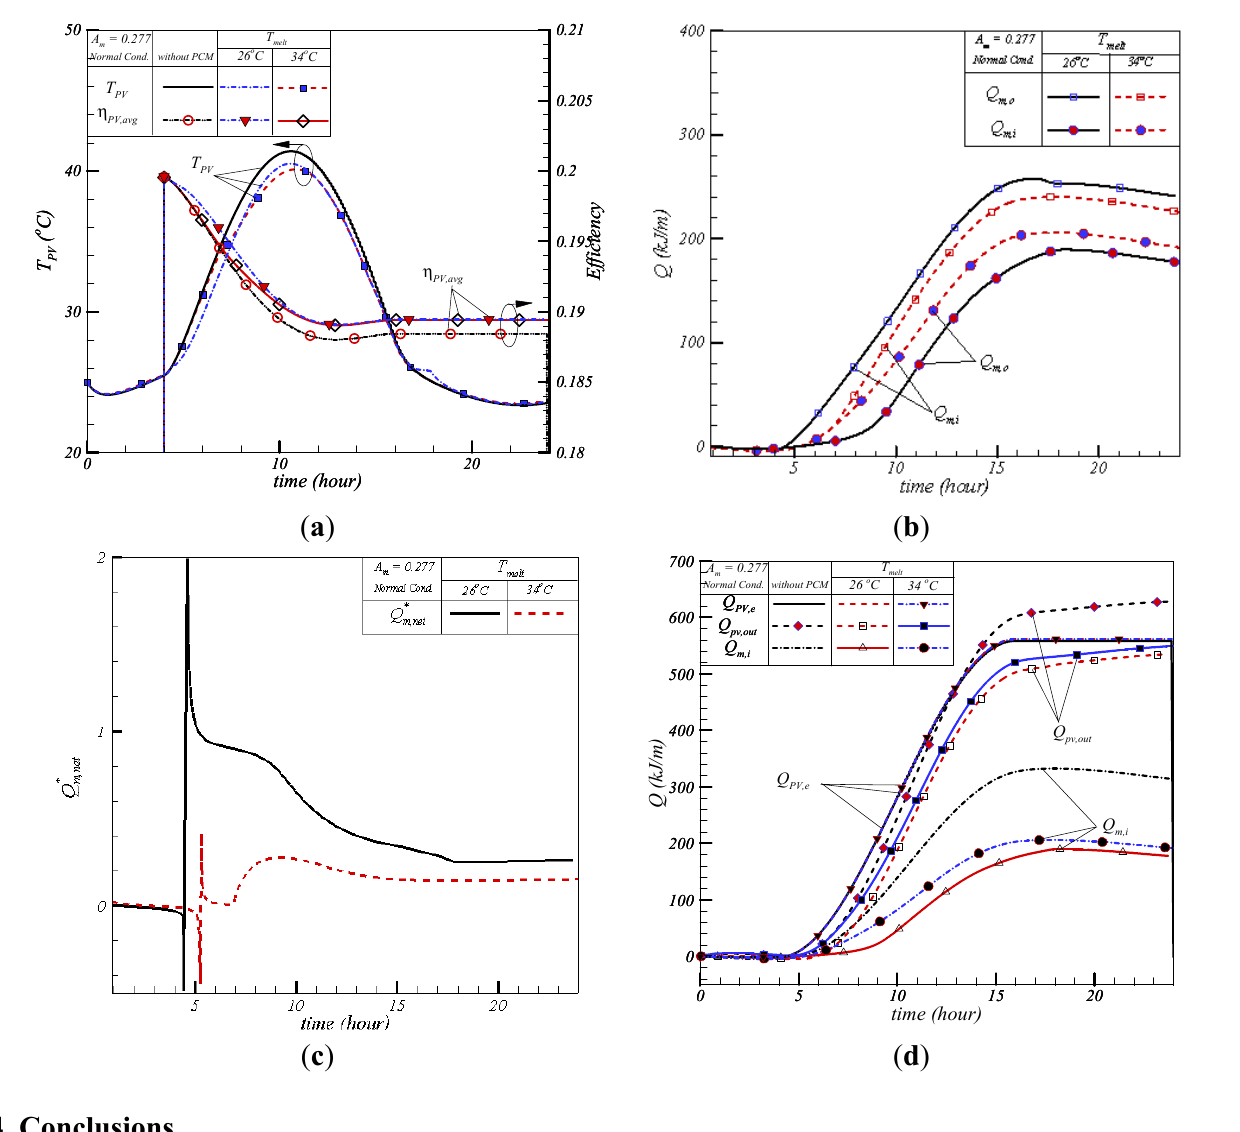
Figure. 4. Thermal and electrical performance of PV module with and without MEPCM = 0.277) with different melting points of T layer ( A m temperature and efficiency of PV cell; ( b ) Total heat transfer rate across the MEPCM layer; ( c ) Fraction of energy stored inside the MEPCM layer; and ( d ) Total heat transfer rate across the PV